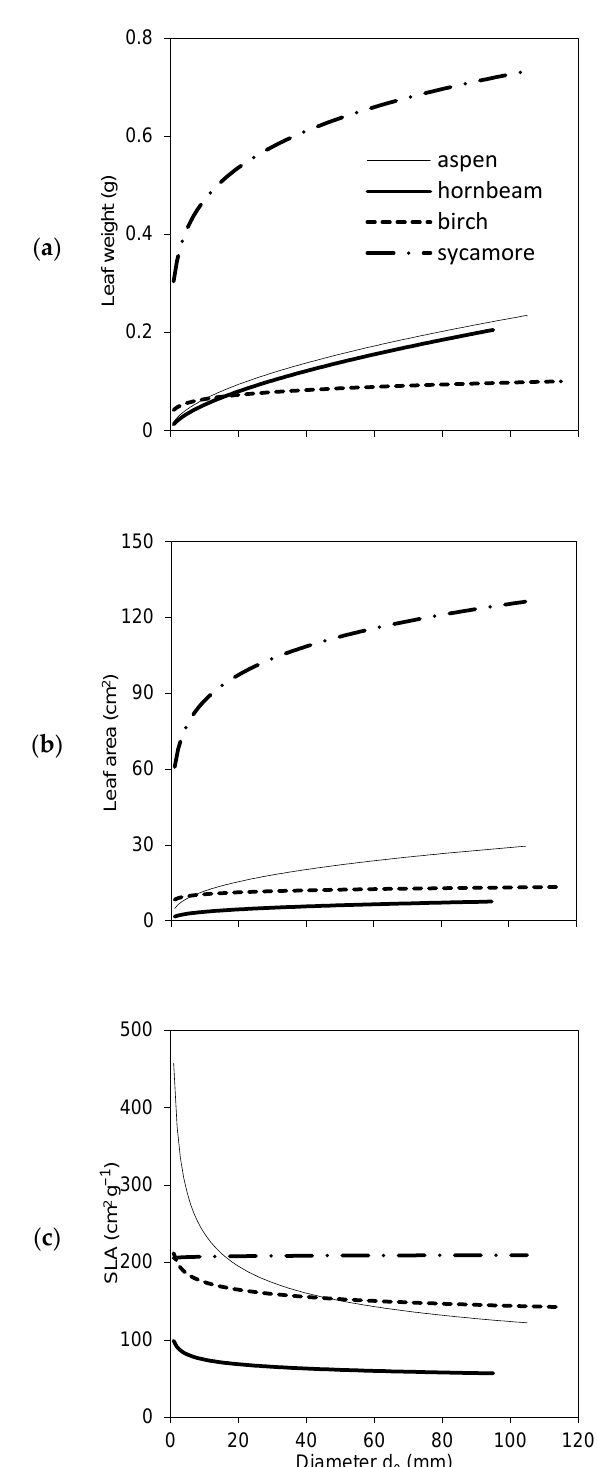
Figure 2. Species-specific models for individual leaf weight ( a ), leaf area ( b ) and specific leaf area (SLA) ( c ) expressed against diameter d 0 (see Table 2 for parameters and statistical characteristics of equations).